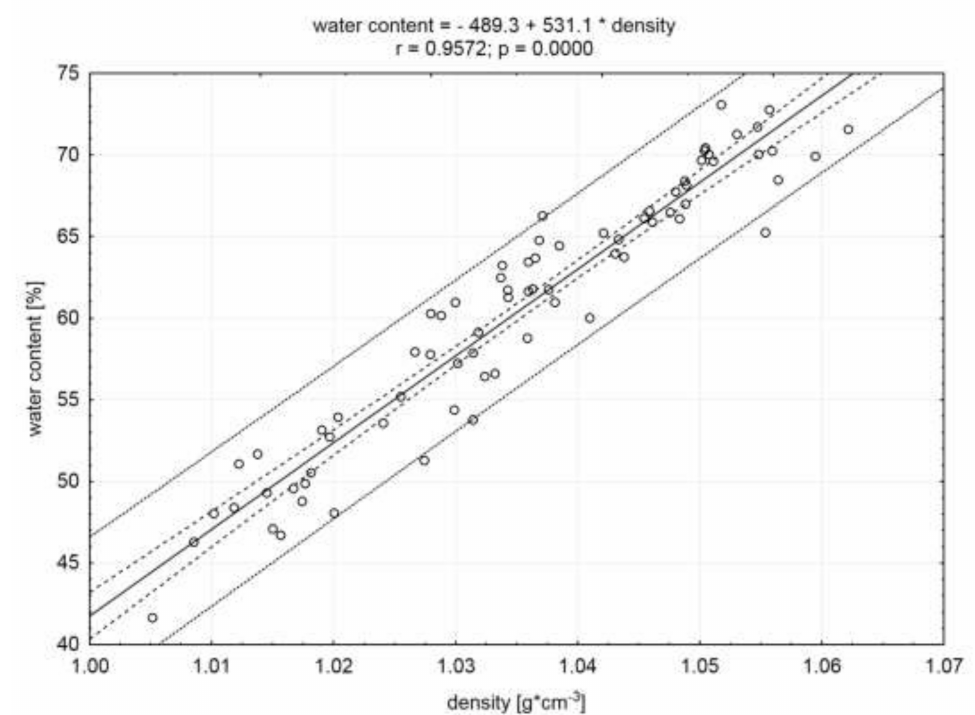
Figure 1. Correlation between water content and density of the meat. Dotted lines indicate the confidence and prediction curves (for the level of 0.95).